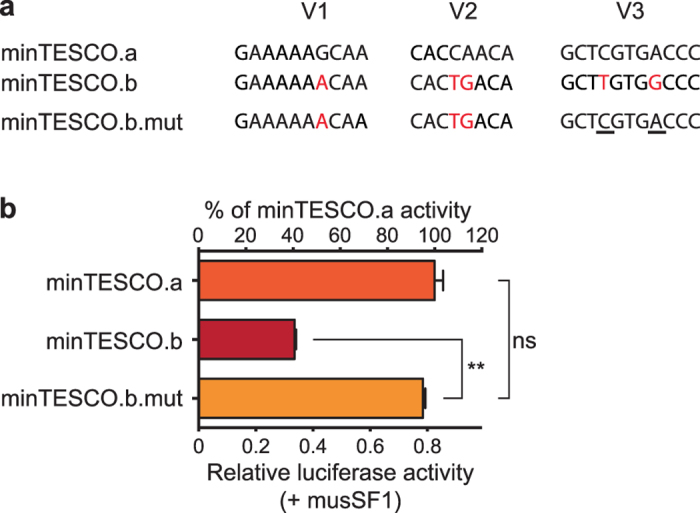
Sequence variations at the V3 site between two haplotypes of M. minutoides TESCO results in reduced enhancer activity.(a) Sequence comparison of V1-3 between minTESCO haplotypes a and b. Sequence changes between the two haplotypes are in red. Mutated bases in minTESCO.b.mut are underlined. (b) Compared with minTESCO.a, minTESCO.b had its transcriptional activity (in the presence of musSF1) halved. minTESCO.b.mut with V3 site mutated to the corresponding sequence in minTESCO.a showed fully restored reporter activity in the presence of musSF1. Data are presented as TESCO luciferase activity normalized to co-transfected CMV-renilla luciferase activity. Error bars: s.e.m. (n = 3). (**) P < 0.01, one-way repeated measures ANOVA with Dunnett’s multiple comparisons test. ns, not significant.